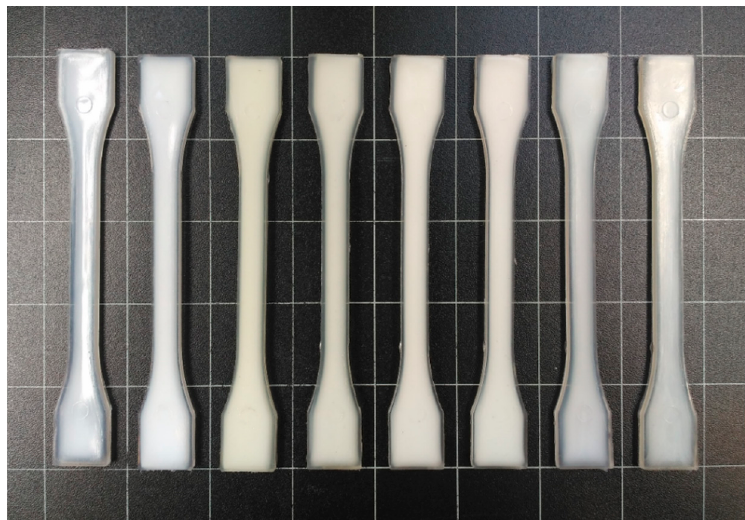
Figure 2. Visual aspect of the injection-molded pieces of the partially bio-based and recycled polyethylene